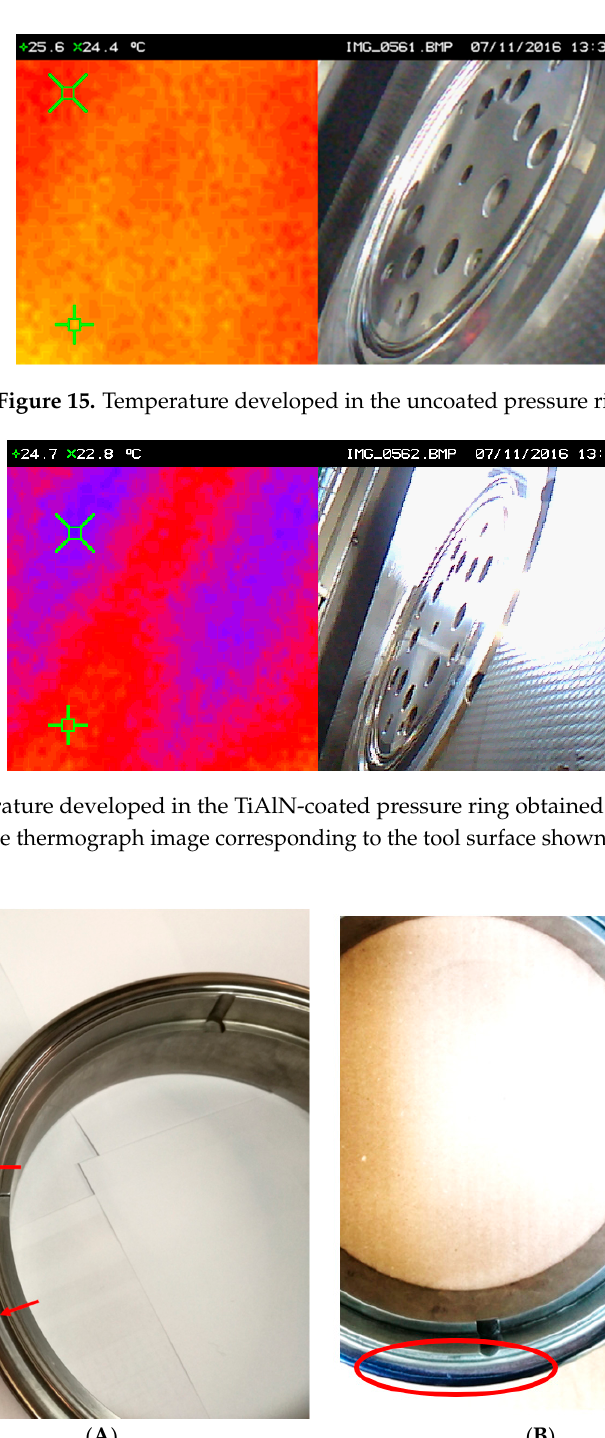
( B ) Figure 17. ( A ) Minor wear signs (indicated by red arrows) on the TiAlN-coated pressure ring after 90,000 stamping cycles; ( B ) Uncoated pressure ring after 90,000 stamping cycles with clear tin transfer on the surface and wear marks (indicated by red oval). 4. Conclusions This work aimed to evaluate the suitability of TiAlN coating to be used in low-deep stamping tools devoted to working with tinplate. Laboratory tests were considered appropriate to analyze the feasibility of the application of TiAlN coatings in stamping tools, which showed that this type of